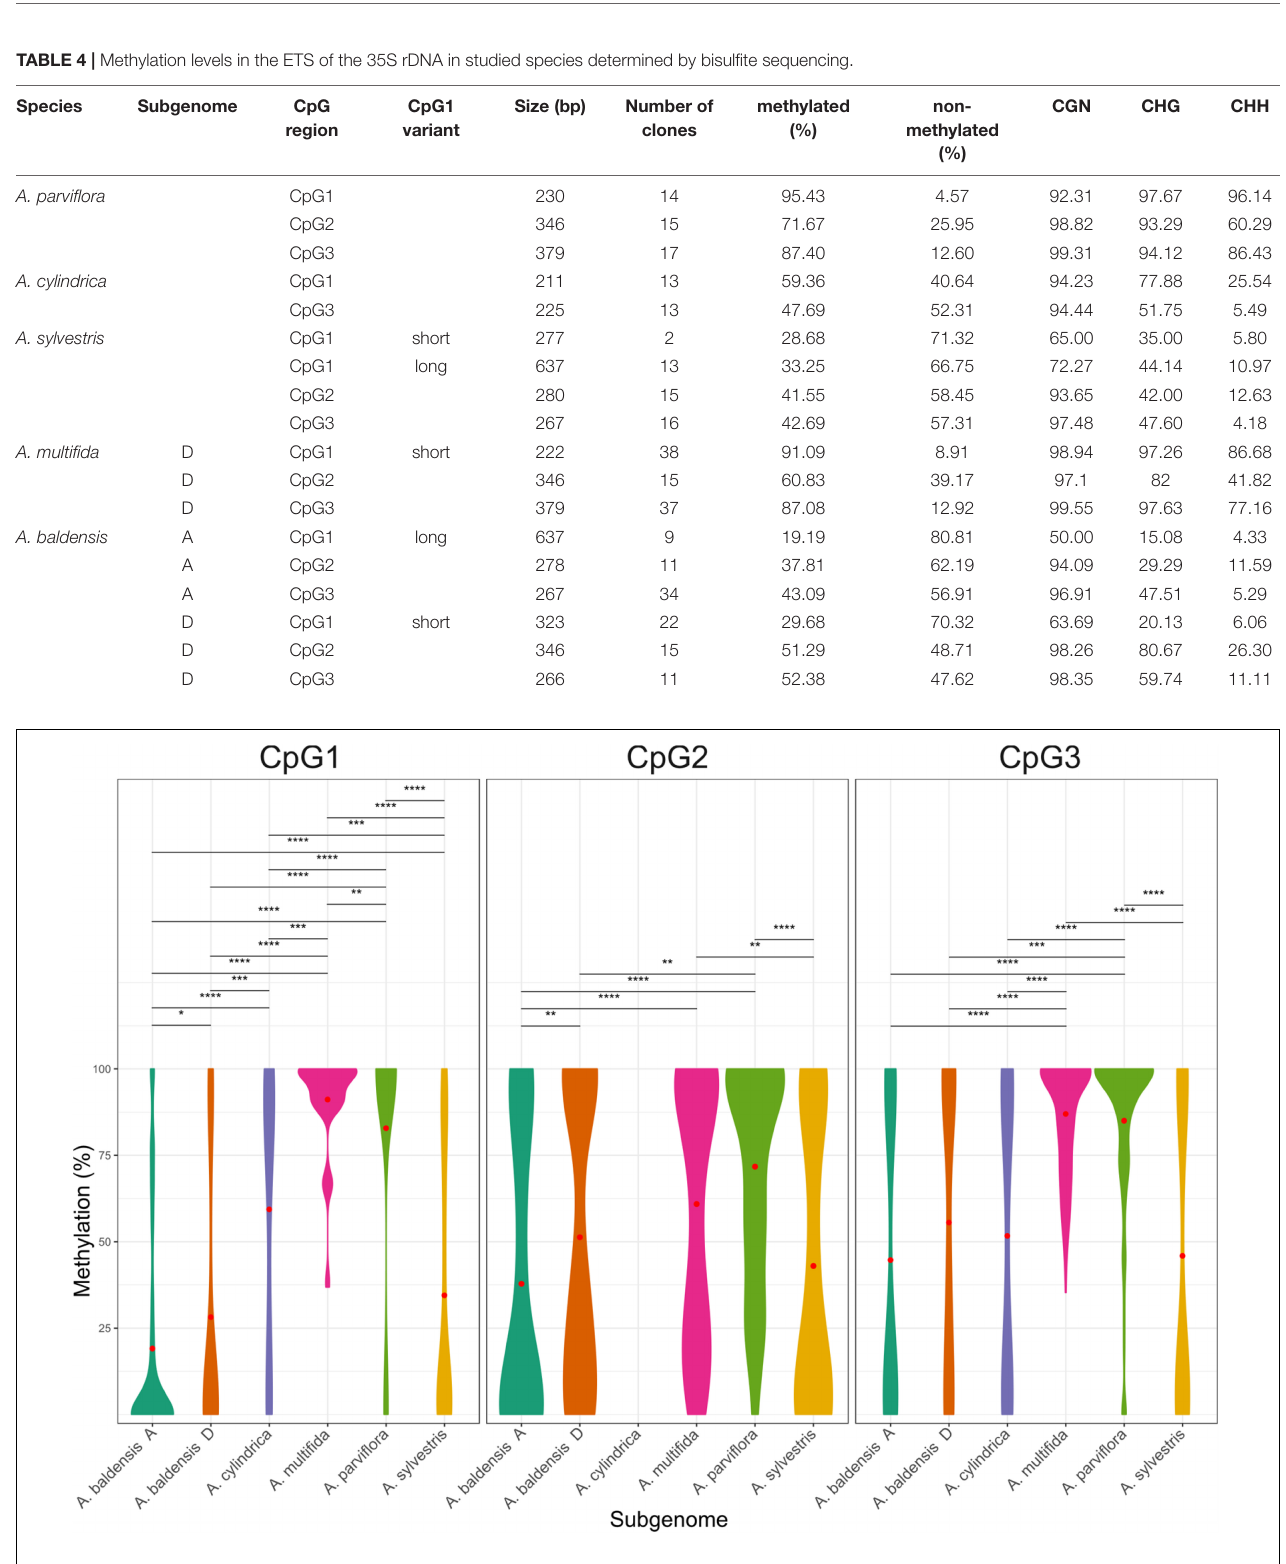
FIGURE 5 | Violin plots representing the overall cytosine methylation level in regions CpG1, CpG2, and CpG3 within the 5 (cid:48) ETS of 35S rDNA established by bisulfite sequencing of Sanger-sequenced clones. Wider regions of the violin plot represent methylation levels that occur more frequently. The values on the graph represent percentage of the methylated clones per each site for each type of modification. Different colors represent different species. Red dots represent mean methylation level. Statistical significance is represented as: * for α ≤ 0.05, ** for α ≤ 0.01, *** for α ≤ 0.001 and **** α ≤ 0.0001.